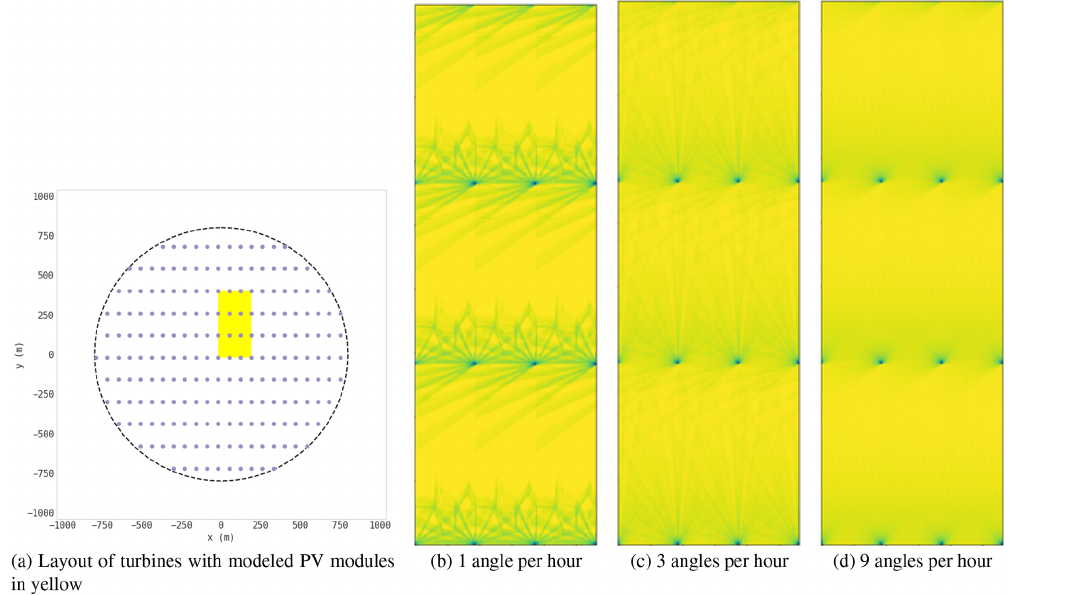
Figure 2. Heat maps (b–d) are of POA loss for a 4 × 4 turbine grid (a) generated by repeating the central grid cell with different simulation resolutions; (b) and (c) both run three time steps per hour, with one or three blade angles per time step. The simulation length for each was a few days.